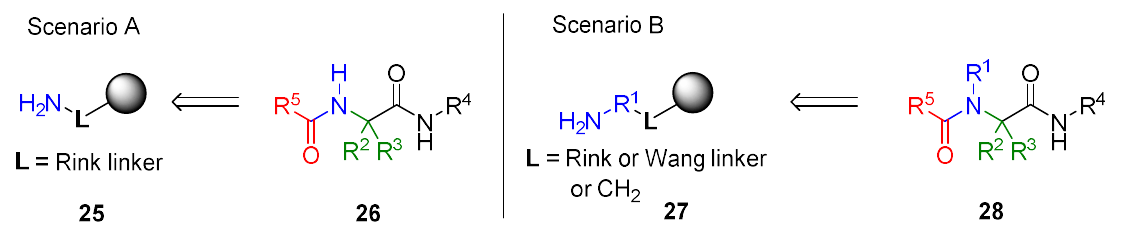
Figure 1. Solid-phase supports most frequently used in the